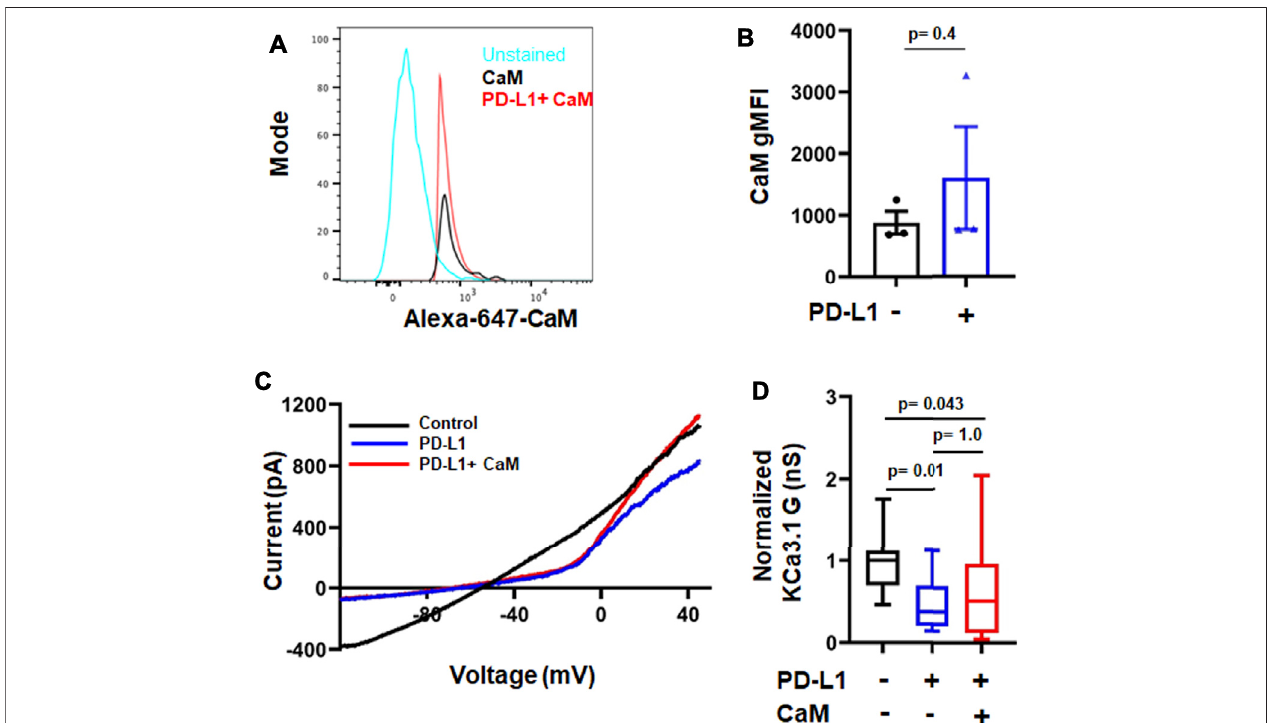
FIGURE 5 | Short-time treatment with PD-L1 decreases KCa3.1 activity in a calmodulin-independent manner. (A) Flow cytometry histogram and geometric mean fl uorescence intensity (gMFI) values (B) for CaM expression in activated CD8 + PBTs from HD donors ( n (cid:1) 3) in the absence and presence of PD-L1. (C) Representative recordings of KCa3.1 currents in activated CD8 + PBTs from HDs showing the effect of PD-L1 (PD-L1-Fc, 10 μ g/ml) and CaM (50 µM). (D) Average normalized KCa3.1 conductance ( G , nS) measured in the absence and presence of PD-L1, with and without CaM. All conductance values are normalized to average conductance valueobtainedfromcontrolrecordings.Cellswerepre-incubatedwithplate-boundPD-L1(PD-L1-Fc,10 μ g/ml,for72 h)activatedusinganti-CD3/CD28antibodiesand treatedwithor without CaM (50 µM), that wasdeliveredintracellularly via patch pipette during recordings( n (cid:1) 15 – 18cells per group from 3HDs). The values inpanel (B) arerepresentedasbargraphs.EachsymbolrepresentanindividualHD.Thevaluesarerepresentedasmean ± SEM.Thevaluesinpanel (D) arerepresentedasboxand whisker plots. The lower and upper bound of the box represent 25 th and 75 th percentiles respectively. Median values are shown as horizontal line. The lower and upper error barsrepresents10 th and90 th percentile respectively. Datainpanel (B) wereanalyzed by t -test and datainpanel (D) wereanalyzed byANOVA onranks ( p (cid:1) 0.008) with Dunn ’ s post hoc analysis.